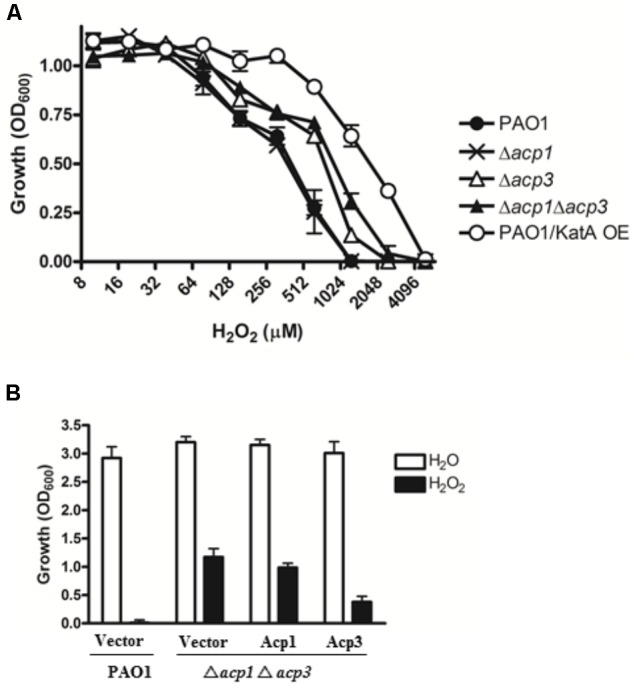
The effect of acp gene deletion or overexpression on P. aeruginosa resistance to H2O2. (A) Δacp3 mutant and Δacp1Δacp3 double mutant were more resistant to H2O2 killing than PAO1 and the Δacp1 mutant. PAO1 overexpressing KatA (KatA OE) was used as a positive control. (B) Effect of ACP overexpression on resistance of P. aeruginosa to H2O2 (2 mM). Complementation of the Δacp1Δacp3 double deletion mutant with a plasmid expressing Acp3 increased susceptibility to H2O2. Data are presented as mean ± SEs from three independent determinations.